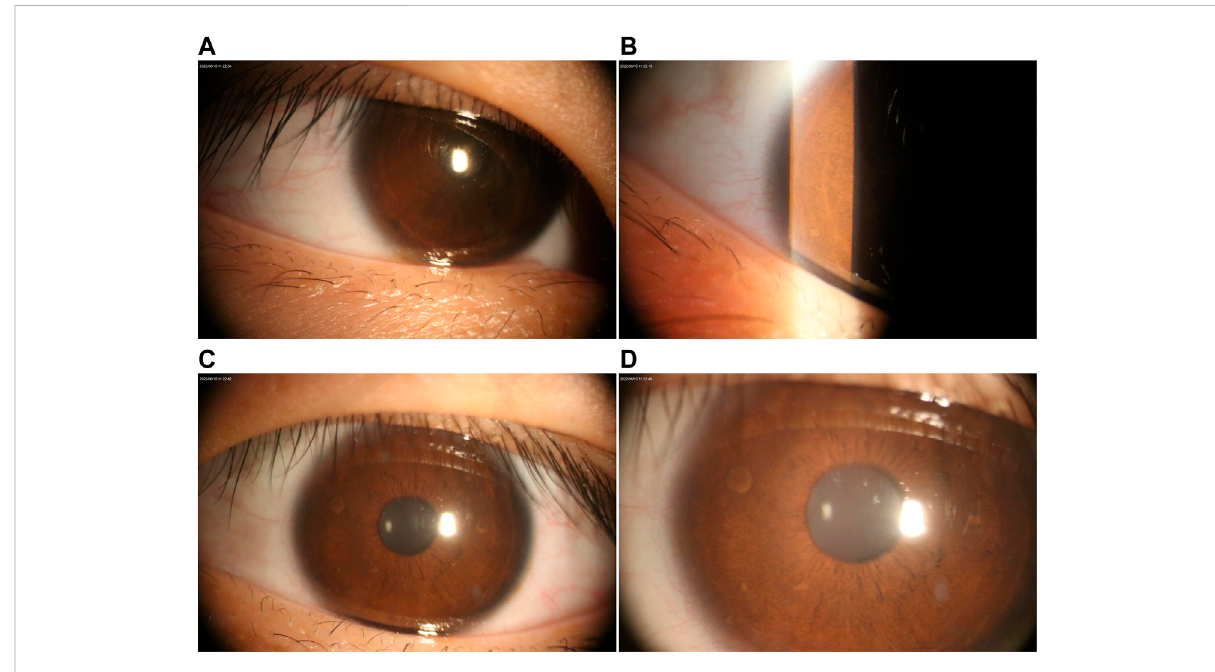
FIGURE 2 Ophthalmological examination under the slit lamp. (A – B) Lisch nodules in the left eye. (C – D) Right eye with multiple Lisch